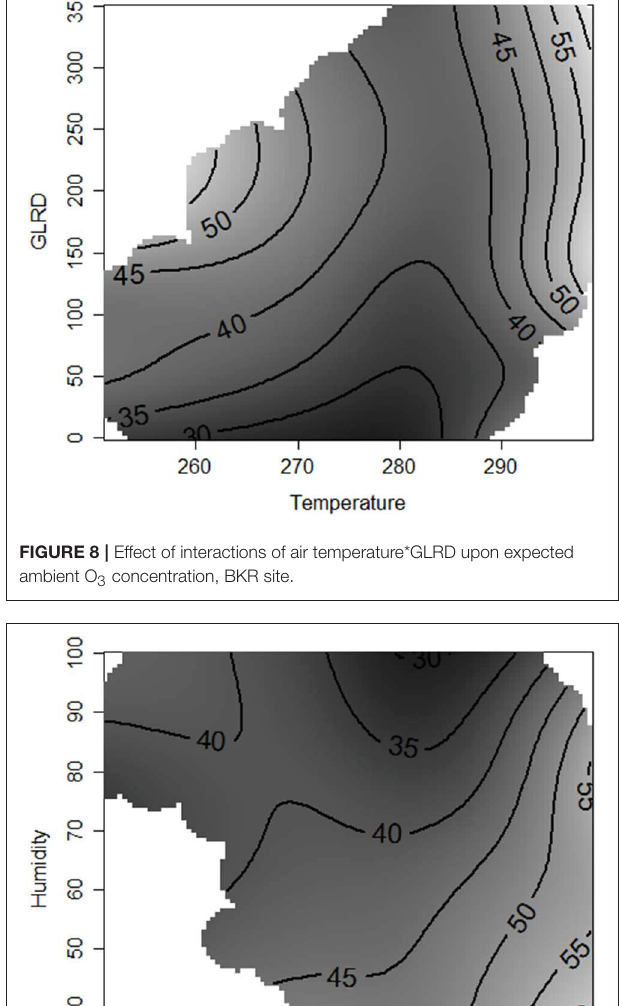
FIGURE 7 | Effect of ambient NO x concentrations upon expected ambient O 3 concentration, BKR site.